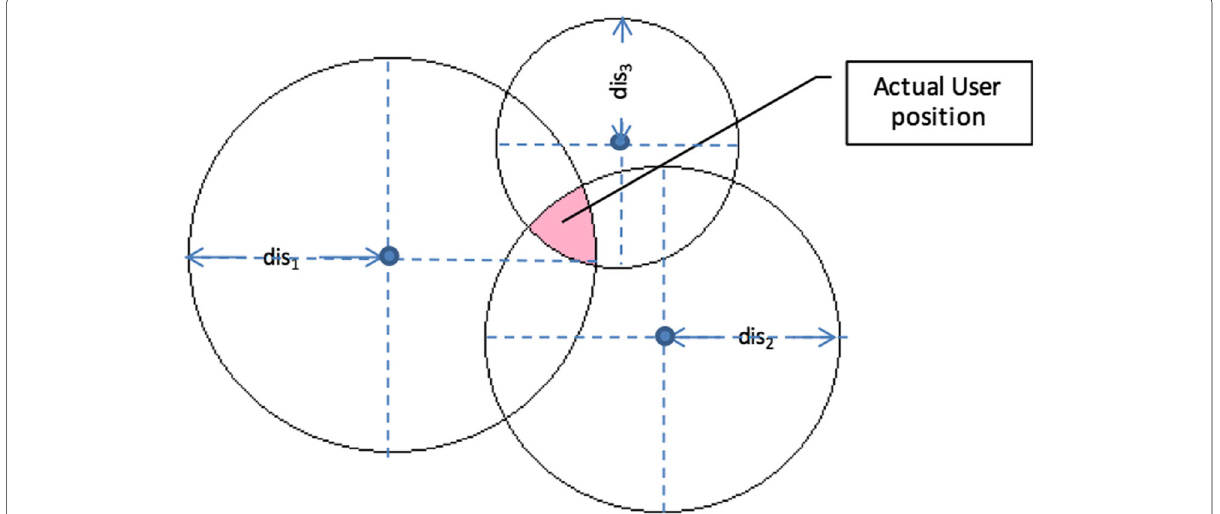
Fig. 3 Trilateration. The pink colored area at the intersection of the three circles defines the possiblepositions of the